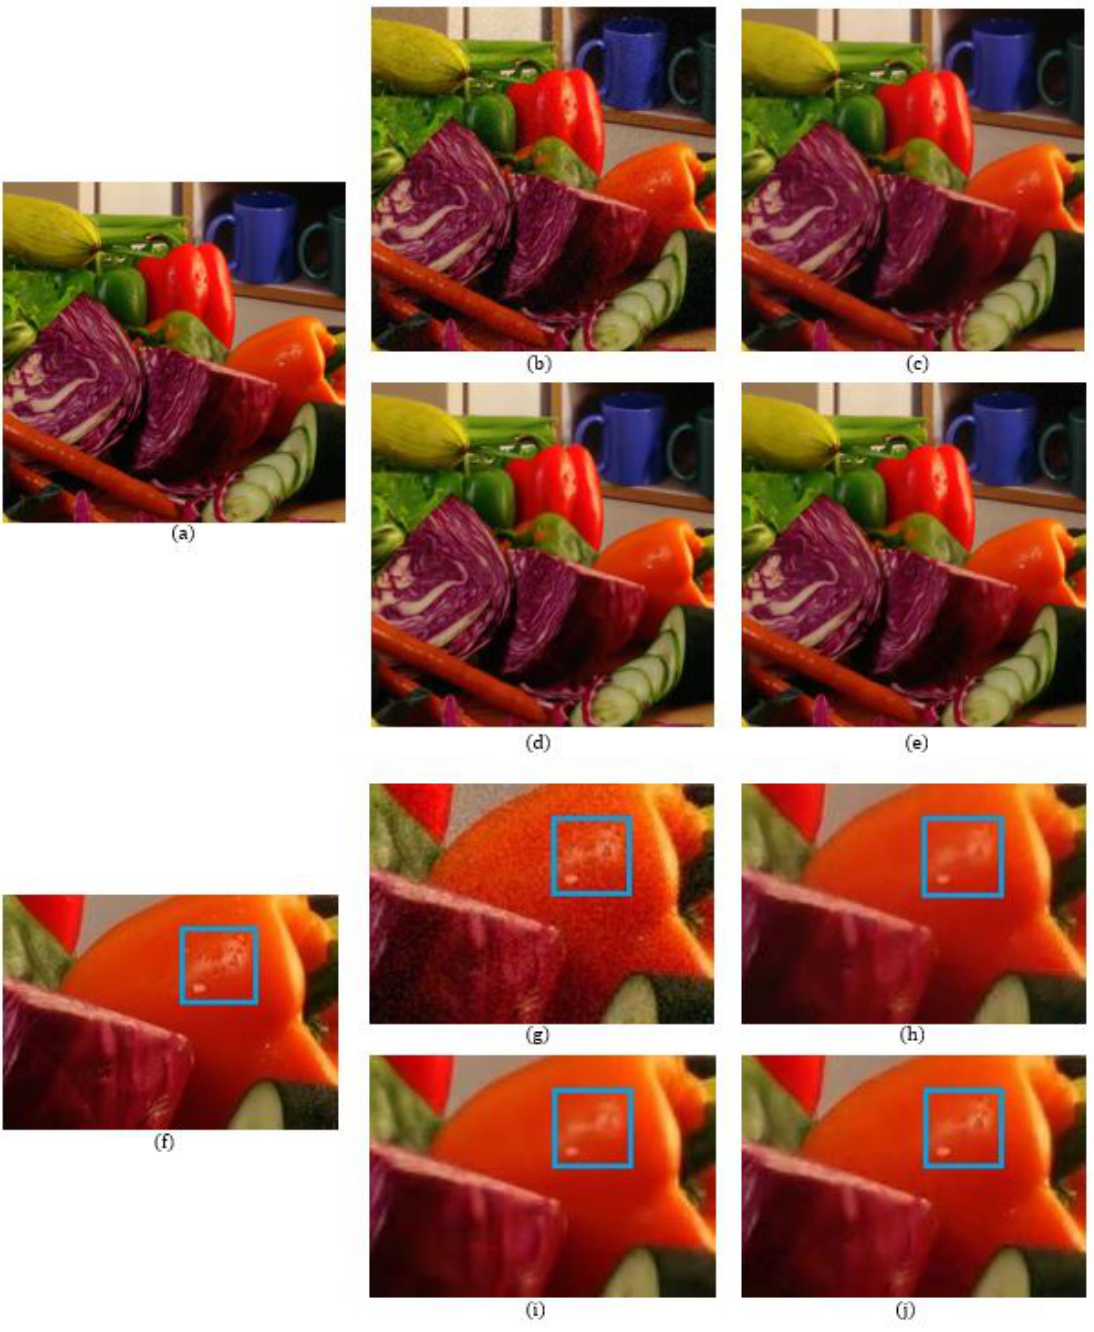
Figure 6. Comparison of the results between the different methods on MCM image 10: ( a , f ) Original; ( b , g ) RI [4] (psnr = 29.2452 dB); ( c , h ) ADMM [9] (psnr = 29.8837 dB); ( d , i ) BM3D [7] (psnr = 30.9424 dB); ( e , j ) proposed (psnr = 30.7439